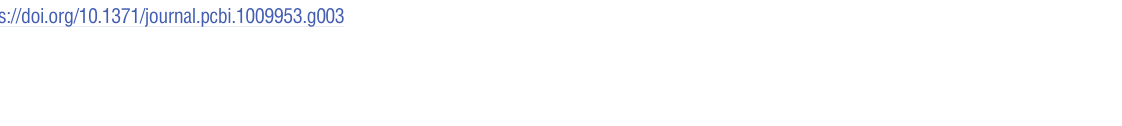
PLOS Computational Biology | https://doi.org/10.1371/journal.pcbi.1009953 March 16,